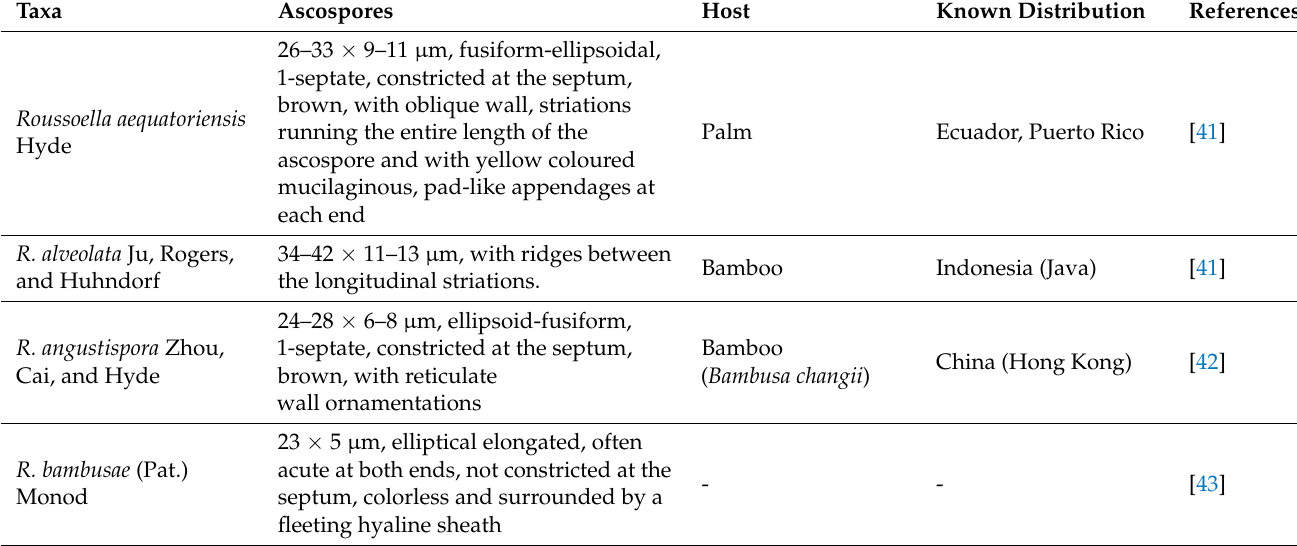
Table 7. Ascospores, host, and distribution comparison of eleven sequence lacking known Roussoella taxa with three new species in this study. “-”: not available in the